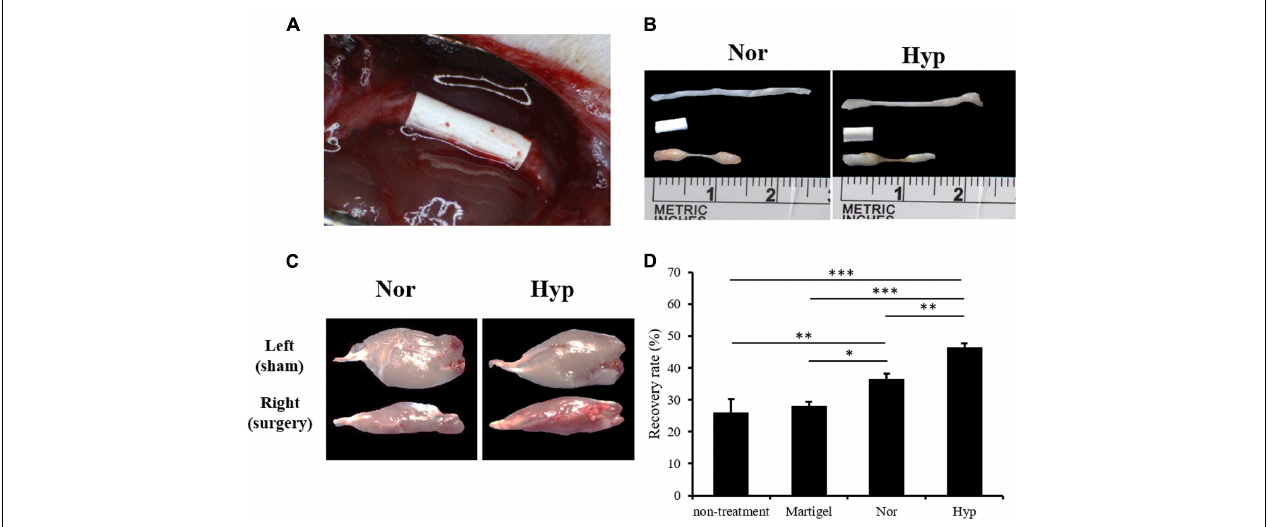
FIGURE 4 | The animal model of the sciatic nerve defect and outcome analysis of the ADSC treatment. (A) A polylactide conduit connecting a 5-mm sciatic nerve defect by surgical implantation in the Sprague-Dawley rats. The animals were sacrificed after 6 weeks. (B) The dissected normal sciatic nerve, implanted conduit, and regenerated nerve from the normoxic, or hypoxic ADSCs were exhibited from the top to the bottom, respectively. (C) The dissected gastrocnemius muscles from the left limbs of the rats as the sham group were showed in the upper panel. The lower panel displayed the atrophied muscles from the right limb with sciatica receiving a treatment of the normoxic or hypoxic ADSCs in the conduits. (D) The weights of the gastrocnemius muscles were measured and normalized with those of the sham group to calculate the recovery rate. The values were presented as mean ± SD with three replicates of the experiments. Statistical significance between the multiple groups was analyzed using the one-way analysis of variance (ANOVA) analysis. “ ∗ ” represented p < 0.05, “ ∗∗ ” represented p < 0.01, and “ ∗∗∗ ” represented p <